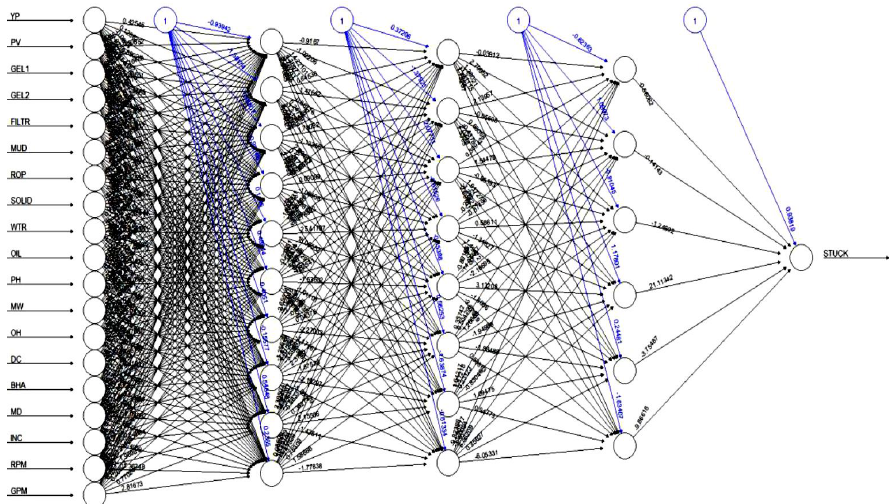
Figure 5. Topology [19, 10, 8, 6, 1] of the best ANN model using the logistic activation function (model no. 580).